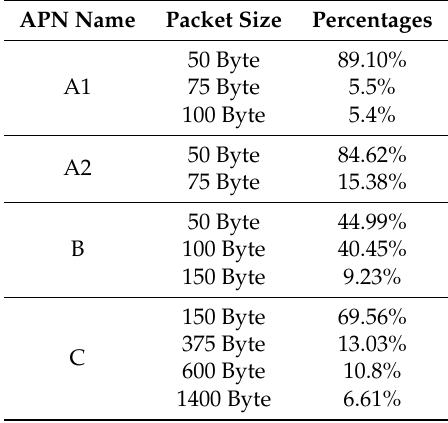
Table 2. Flows packet size distribution on different APNs.